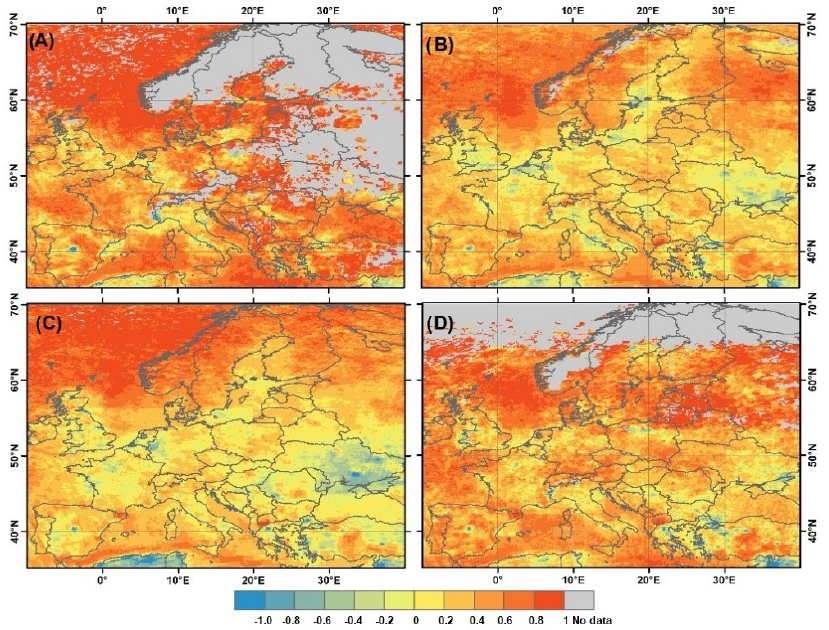
Figure 4. Correction ratio values (F) for NOx emission based on satellite data and GEM–AQ model results. ( A ) February, ( B ) May, ( C ) August, and ( D ) November.